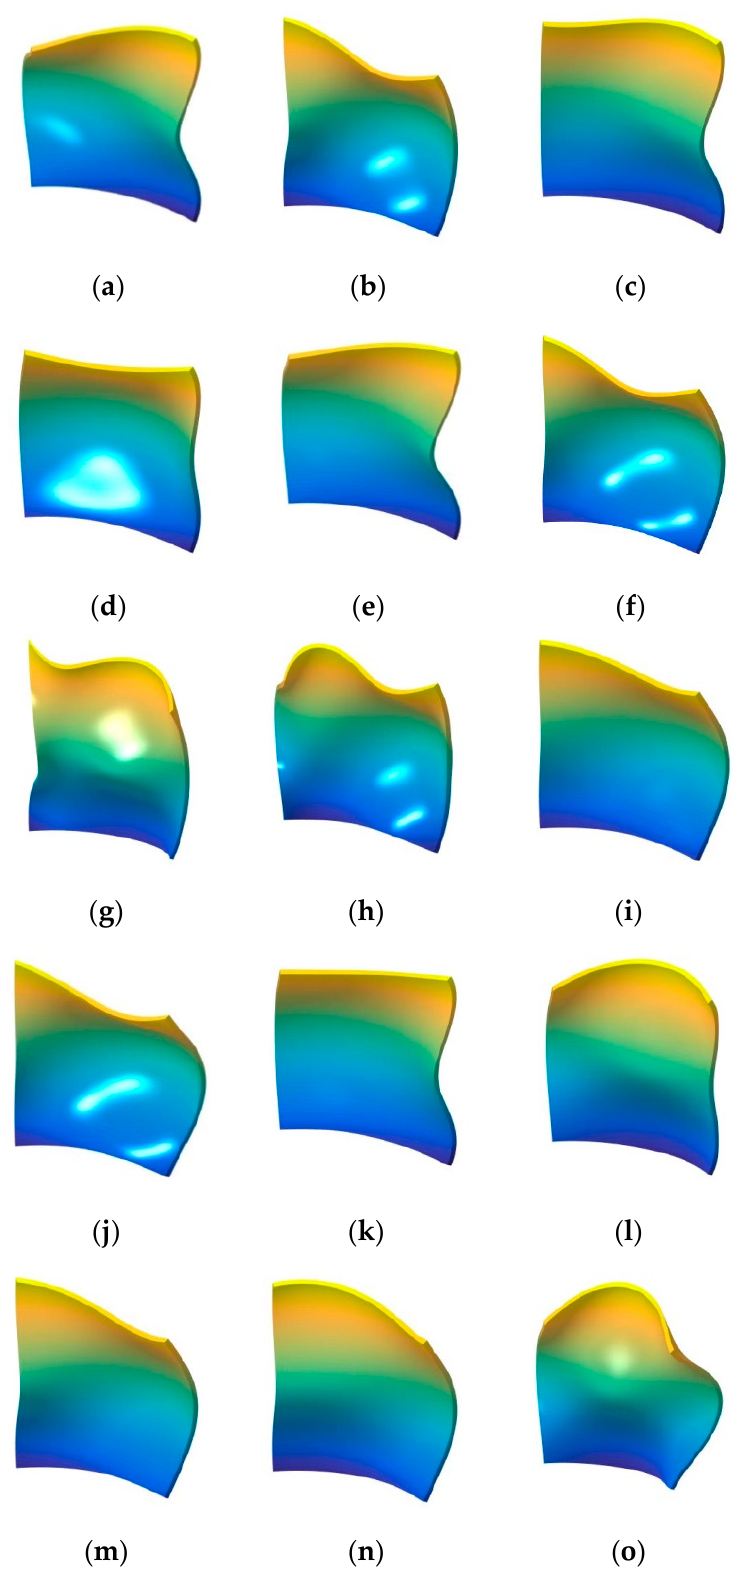
Figure 3. The mode shapes for the composite laminated shallow spherical shell with various boundary conditions. ( a ) C-C,(1,1); ( b ) C-C,(1,2); ( c ) C-C,(1,3); ( d ) F-C,(1,1); ( e ) F-C,(1,2); ( f ) F-C,(1,3); ( g ) F-F,(1,1); ( h ) F-F,(1,2); ( i ) F-F,(1,3); ( j ) F-S,(1,1); ( k ) F-S,(1,2); ( l ) F-S,(1,3); ( m ) S-C,(1,1); ( n ) S-C,(1,2); ( o ) S-C,(1,3).